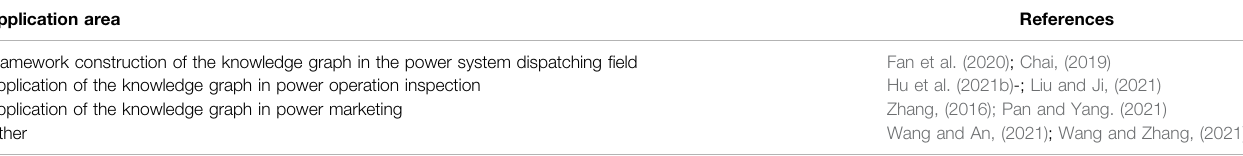
TABLE 1 | Research on the application of knowledge graphs in the fi eld of power system dispatching. Application area